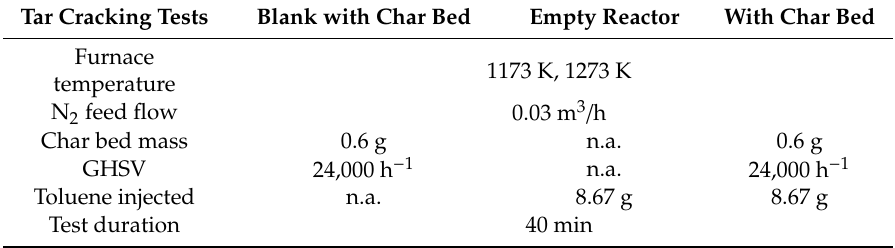
Table 1. Experimental tests operating conditions. GHSV: Gas hourly space velocity.